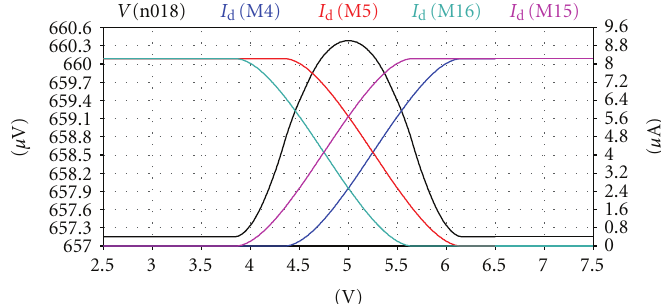
Figure 12: Gaussian-shaped membership function, V b3 = 1 . 65 V.